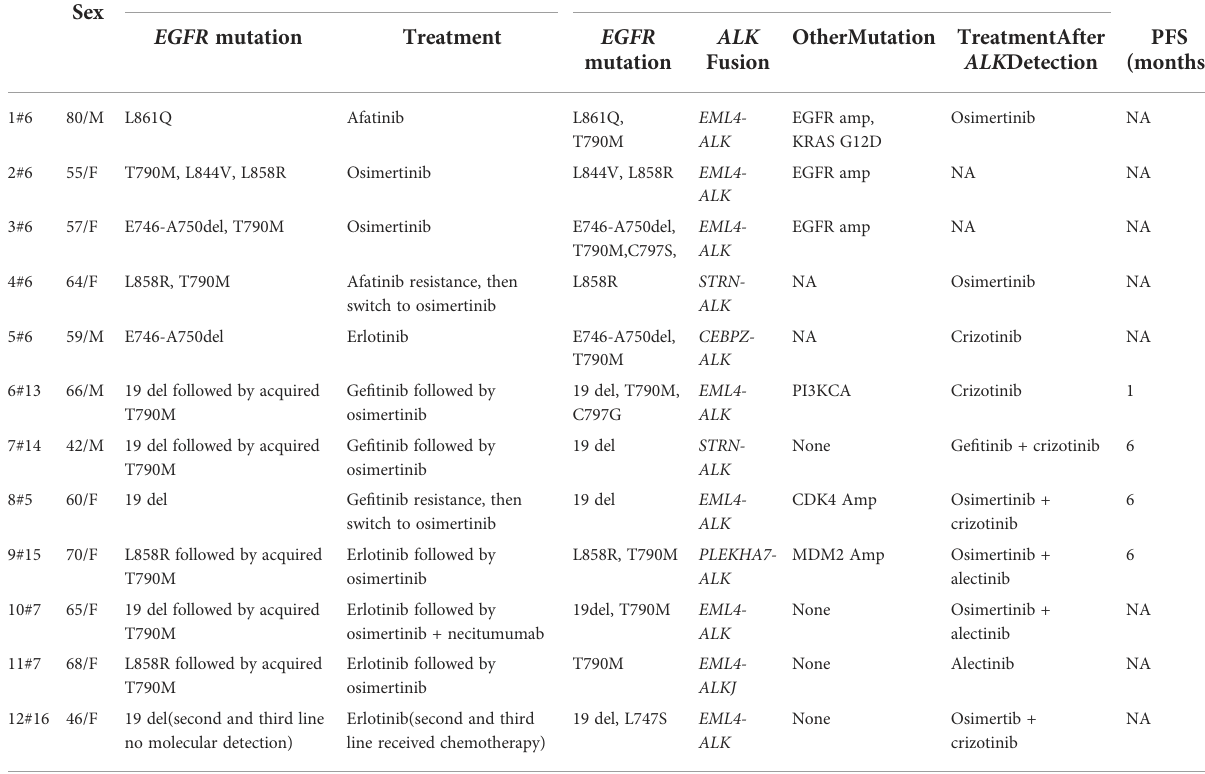
EML4-ALK, echinoderm microtubule – associated protein like 4-anaplastic lymphoma kinase; EGFR, epidermal growth factor receptor; del, deletion; TKI, tyrosine kinase inhibitor; PFS, progression-free survival; M, male; F, female; KRAS, Kirsten rat sarcoma viral oncogene homolog; amp, amplication; NA, not available, PI3KCA, phosphatidylinositol-4,5-bisphosphate 3- kinase catalytic subunit